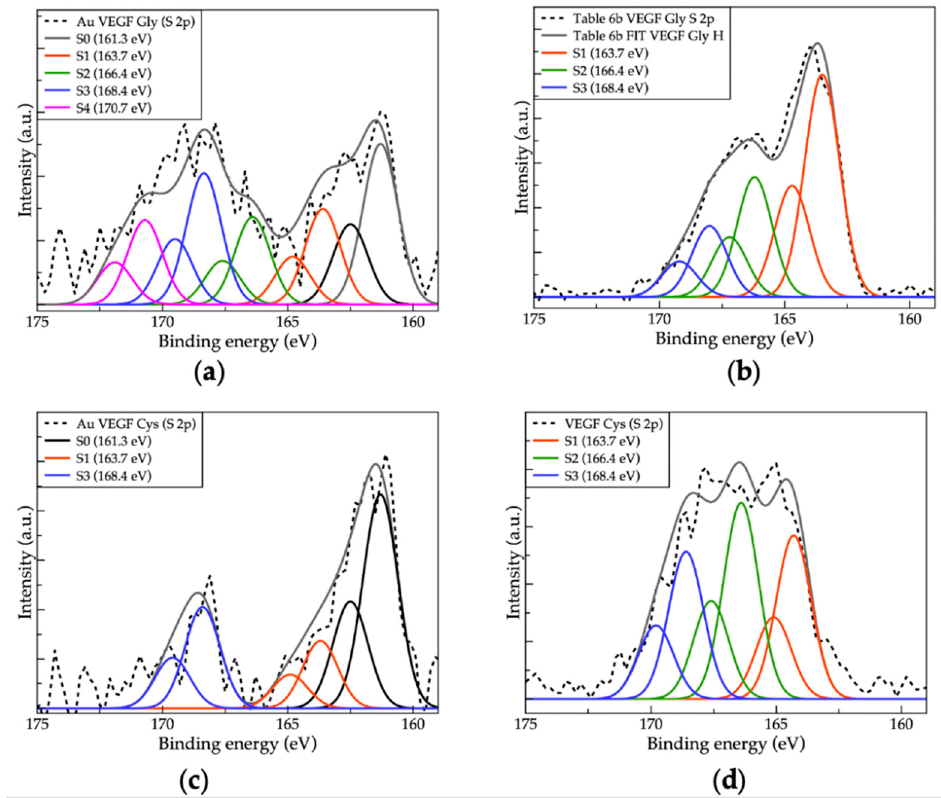
Figure 6. Representative high-resolution spectra and peak fitting curves of S 2p in AuNPs/VEGF Gly-